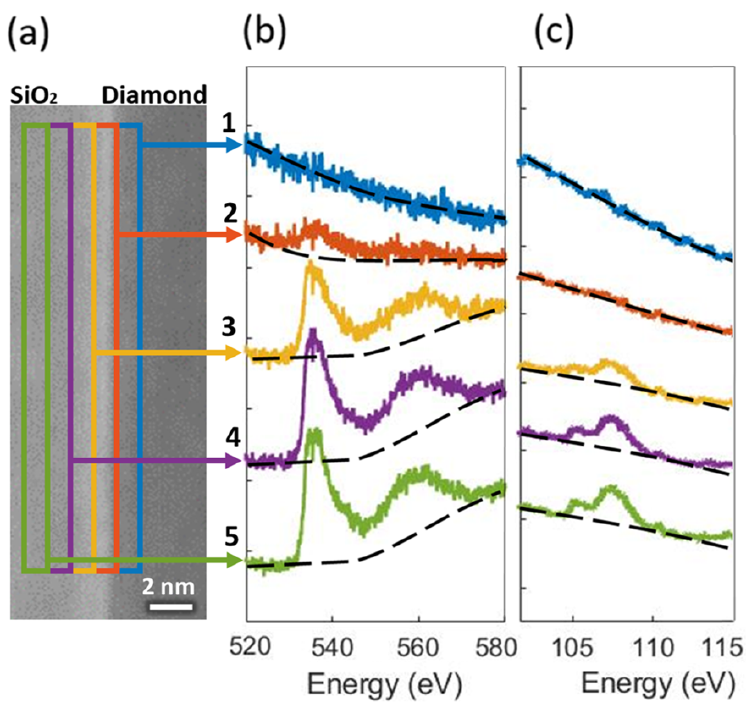
Figure 4. ( a ) ADF image of the SiO 2 –diamond interface displaying the analysis regions for EELS. EELS spectrum of ( b ) O K-edge and ( c ) Si L-edge in the near-interfacial region. Using the data provided in the Table 1, a value of 2.0 eV was deduced, in relatively good agreement with the previously deduced value, thus validating this latter